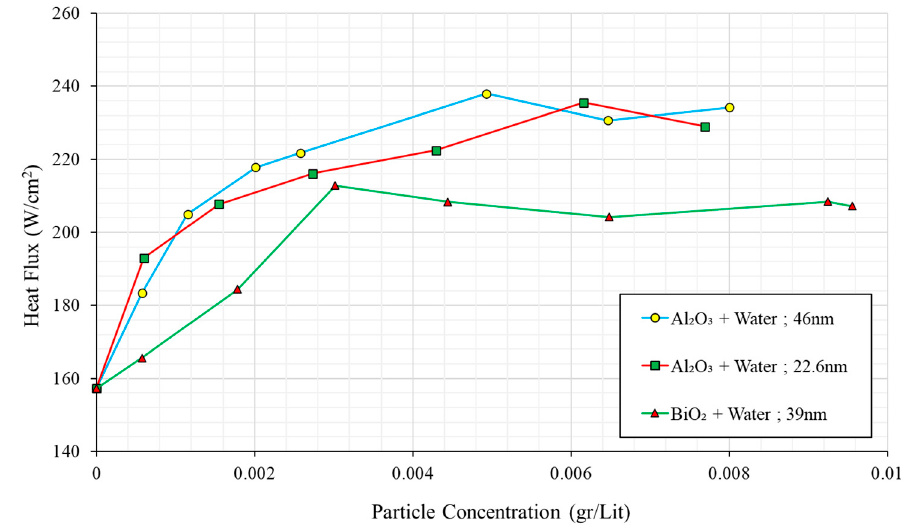
Figure 7. CHF evaluation under variations of particle concentration, material and size. Reproduced from [105], Elsevier: 2009.